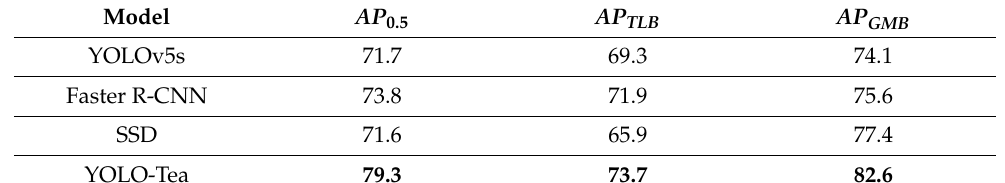
Table 6. The data from the comparative experiments.